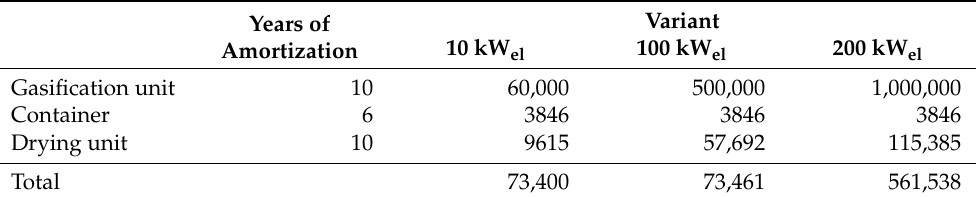
Table 5. Investment costs for gasification technology in EUR.